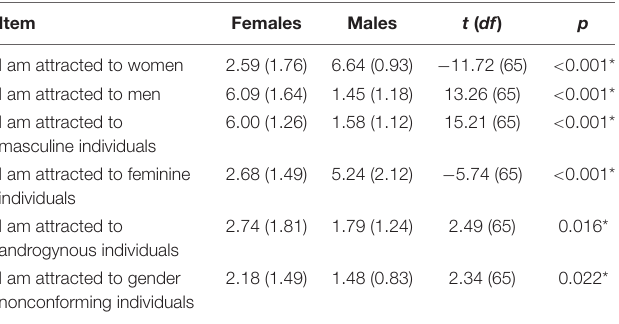
TABLE 3 | Mean differences (and standard deviations) in female and male participants regarding items of the Gender Inclusive Scale.